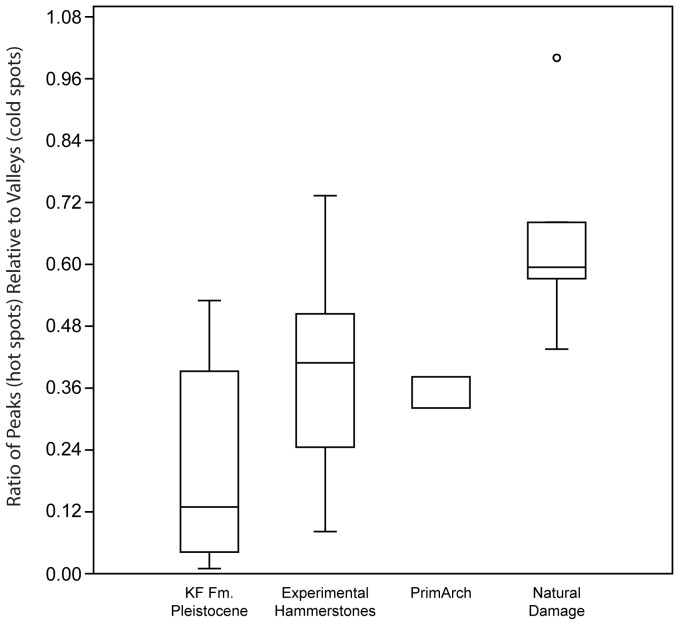
Box-plot of the ratio of hot spot (peaks) polygon area relative to cold spot (valleys) polygon area.Boxes represent the interquartile ranges for the four samples (archaeological specimens from Pleistocene deposits of the KF Fm.; experimental percussive specimens; PrimArch specimens from the KF Fm. (>2.2 Ma); and naturally damaged specimens).